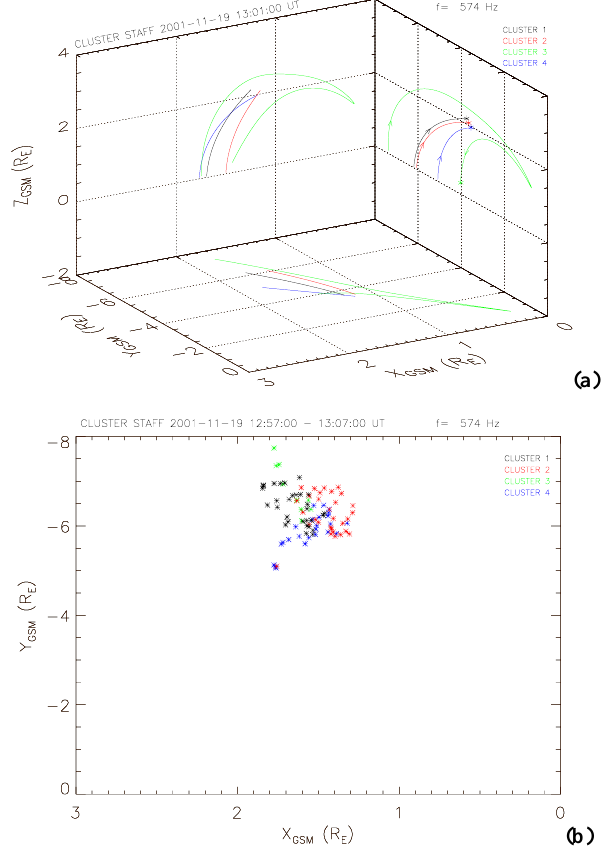
Fig. 3. Results of the ray tracing performed on 19 November 2001 at a frequency equal to 574Hz. (a) 2-D projections of one 3-D trace are represented for each SC according to their allocated colors at 13:01UT. The arrows in the plane YZ indicate the real trajectory of the waves. The stars indicate the positions of the SC. (b) Location of the equator crossing in the equatorial plane for each SC between 12:57 and 13:07UT.